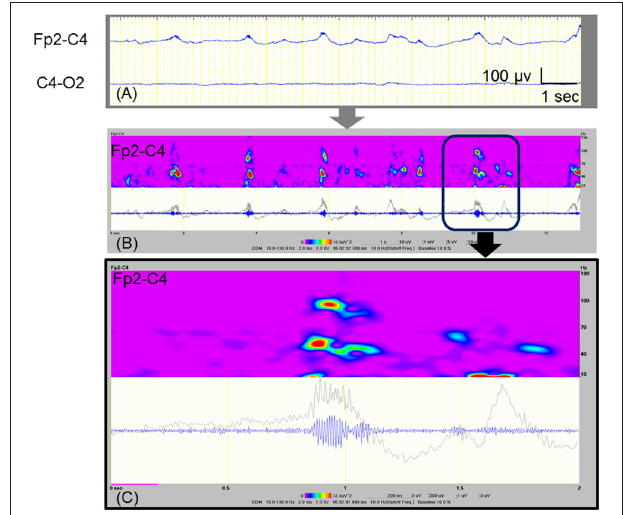
FIGURE 1 | Ictal EEG with FOs that were recorded at 11 days of age. (A) Raw EEG traces, which are analyzed as shown in (B) . (B) Time–frequency analysis of the EEG data at Fp2-C4 that is shown in (A) , using the Complex Demodulation Method. The gray trace is unfiltered, and the blue trace is applied with a high pass filter at 80Hz. The area indicated by the square corresponds to expanded data shown in (C) . (C) The detected high-gamma (71.4–100Hz) activities appear to be temporally independent of the low-gamma